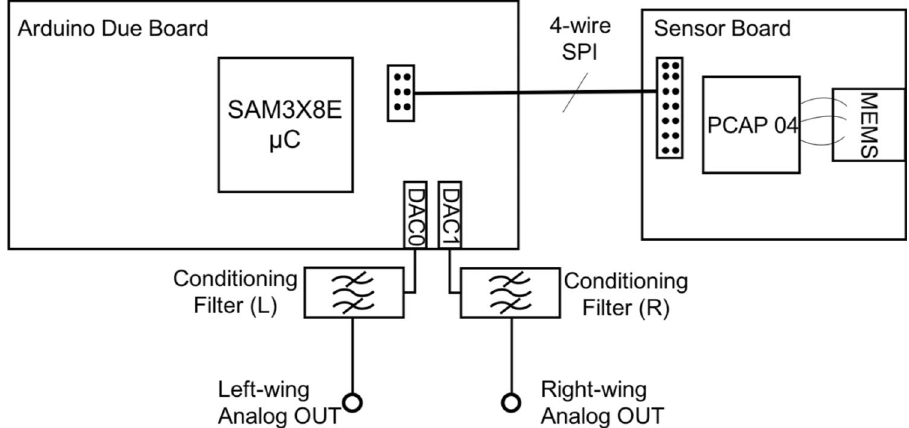
Figure 5. Electronic circuit diagram. The interdigitated comb finger capacitors associated with each wing were connected to one independent input of the PCAP04 capacitance-to-digital converter. Simultaneous wing capacitance readings were taken from PCAP04 output registers and transmitted through a four-wire serial peripheral interface (SPI) to a commercial 32-bit microcontroller evaluation board (Arduino Due). Each of the on-chip digital-to-analog converters (DAC) output a voltage associated with each wing mechanical displacement, resulting two analog signal channels: L (left) and R (right). Conditioning filter networks were used on each channel to further improve signal